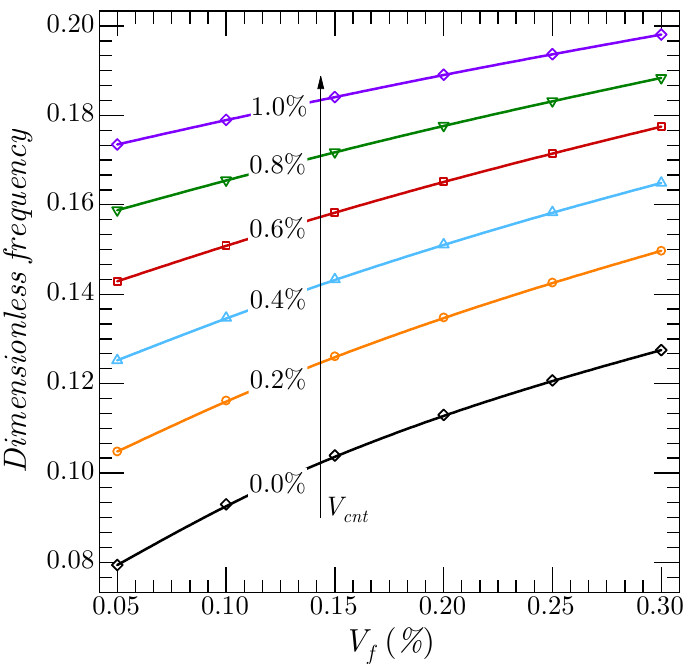
Figure 6. The effect of the volume fraction of fibers and CNTs (Plate, Cross-ply, SSSS, 𝑁 = 9 , 𝑏/𝑎 = 1 , 𝑎/ℎ = 10 , 𝑉 (cid:3040)(cid:3036)(cid:3041)(cid:3033) = 0.05 ). The effect of both the aspect ratio b / a and the thickness ratio a / h on the dimensionless frequency of a spherical shell (cid:3435)𝑅 (cid:3051) 𝑎⁄ = 𝑅 (cid:3052) 𝑏⁄ = 5(cid:3439) for various boundary conditions is demonstrated in Figure 7. The increase in the aspect ratio led to a decrement in the dimen- sionless frequencies regardless of the boundary condition type. For the thickness ratio a / h effect, the frequencies decreased critically for values 𝑎/ℎ ≤ 10 . The fully clamped shells had the highest values of frequency, while the lowest values were for the simply sup- ported shells.